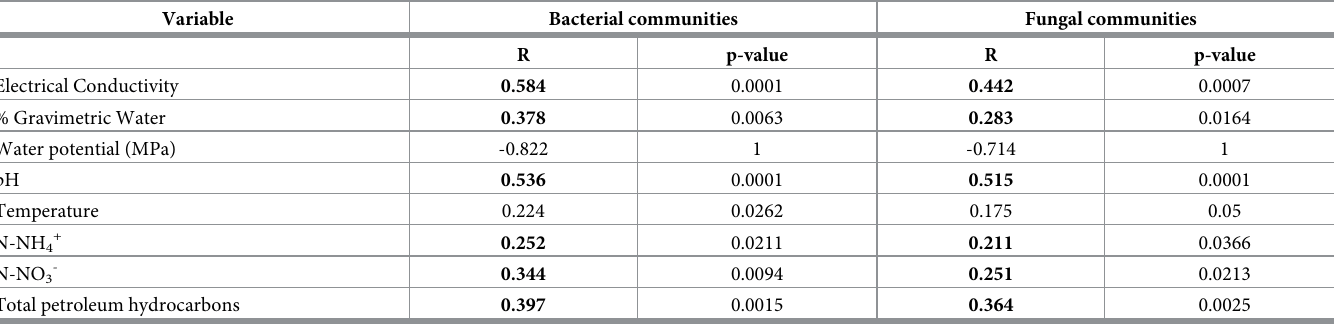
Table 2. Mantel test results correlating OTU-based structure of soil prokaryotic and fungal communities with soil physicochemical properties in the vegetated soil at the peripheral sites, V-East and V-West and in the central vegetated (CV) and un-vegetated (UV) soils at the central SWMU site.